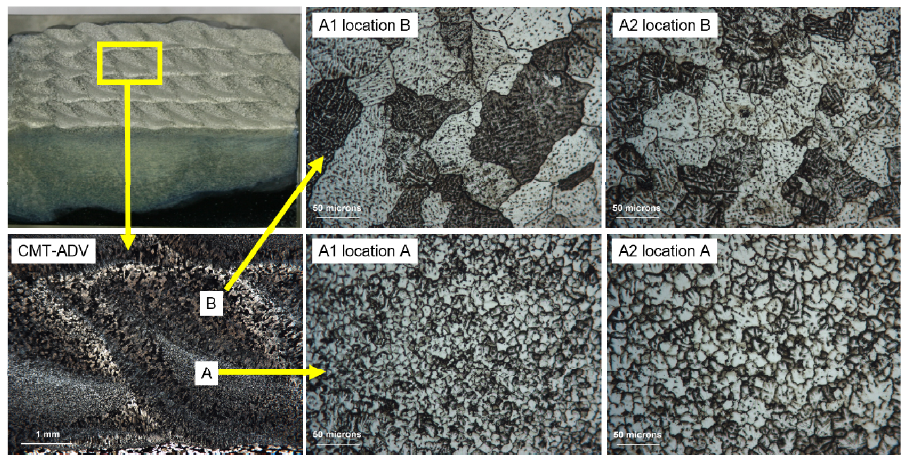
Figure 11. The microstructure of block samples formed with the CMT ‐ ADV process.